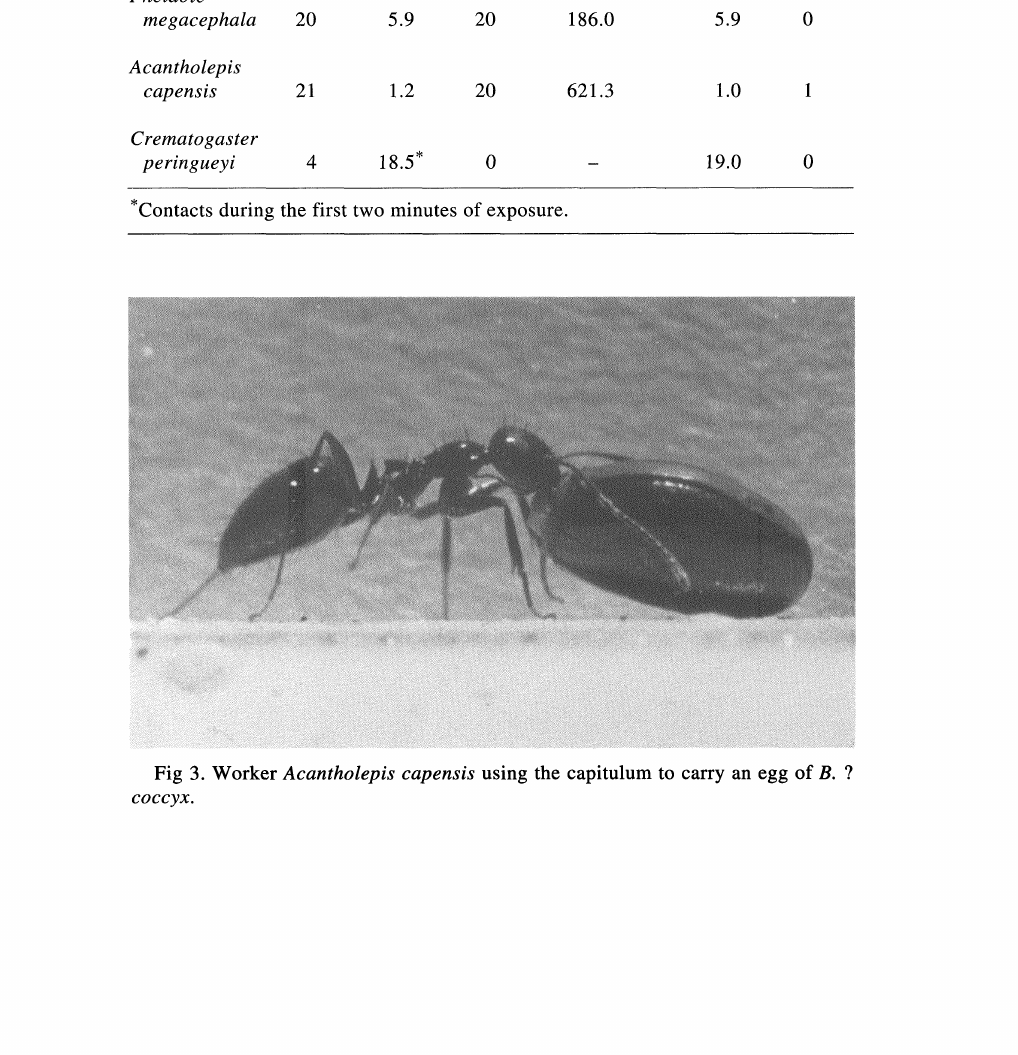
Fig 3. Worker Acantholepis capensis using the capitulum to carry an egg of B. ?